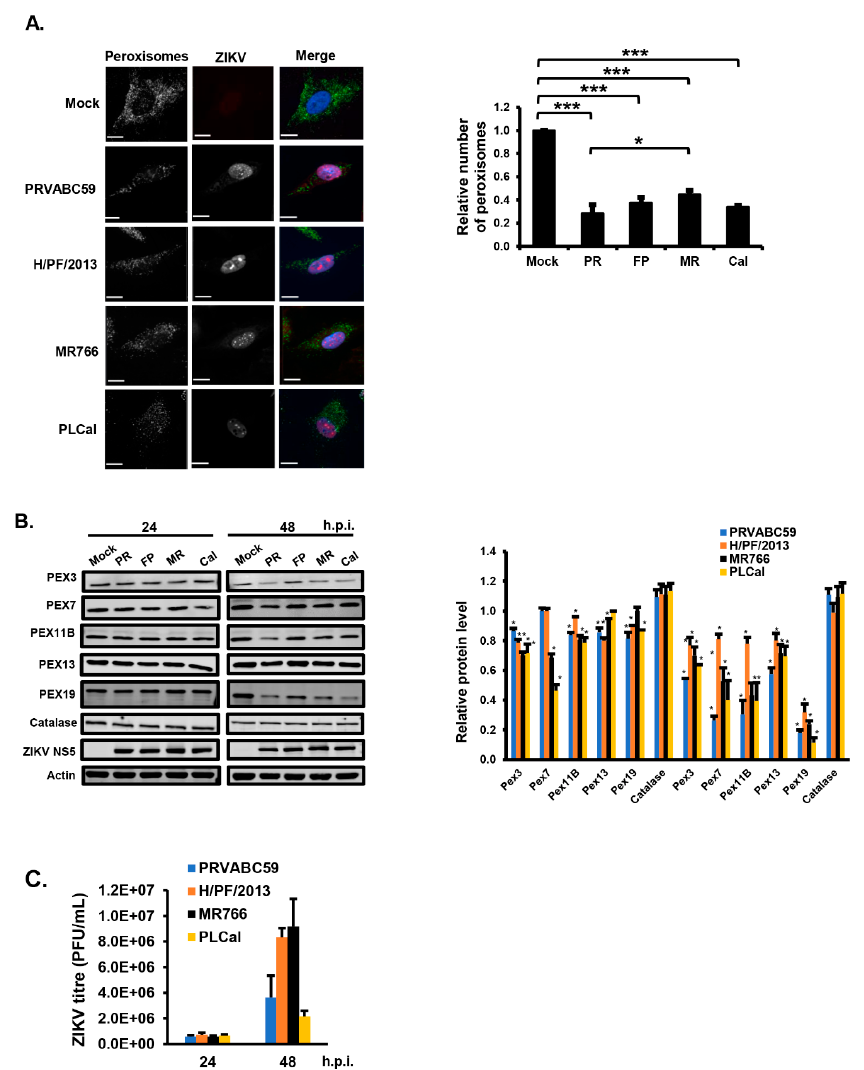
Figure 1. Zika virus (ZIKV) infection decreases the pool of peroxisomes in primary human fetal astrocytes (HFAs). ( A ) HFAs were infected at the multiplicity of infection (MOI) of 3) with ZIKV (PRVABC59 (PR), H/PF/2013 (FP), MR766 (MR) or PLCal (Cal) strains) for 48 h and then processed for confocal microscopy. Peroxisomes were detected using a mouse monoclonal to PMP70 and donkey anti-mouse IgG conjugated to Alexa Fluor 488. Infected cells were detected using a goat polyclonal antibody to ZIKV NS5 and chicken anti-goat IgG conjugated to Alexa Fluor 647. Nuclei were stained with DAPI (4’,6-diamidino-2-phenylindole). Images were obtained using a spinning disc confocal microscope. The number of peroxisomes in mock- and ZIKV-infected cells were determined using Volocity image analysis software. Averages were calculated from three independent experiments, in which a minimum of 20 cells for each sample were analyzed. The average number of peroxisomes in mock-treated cells was normalized to 1.0. Bars represent standard error of the mean. *** p < 0.001, * p < 0.05. ( B ) HFAs were infected with ZIKV strains (MOI = 5) for the indicated time periods, after which total cell lysates were processed for immunoblot analyses with antibodies to catalase, PEX3, PEX7, PEX11B, PEX13, PEX19, ZIKV NS5 and actin. The relative levels of peroxisomal proteins (compared to actin) from three independent experiments were averaged and plotted. The average levels of peroxisomal proteins in mock-infected cells were normalized to 1.0. Error bars represent standard error of the mean. * p < 0.05. ( C ) HFAs were infected with ZIKV (MOI = 1) for the indicated time periods, after which the viral titers in the media were determined by plaque assay. The data are averaged from the results of three independent experiments. Bars represent standard error of the